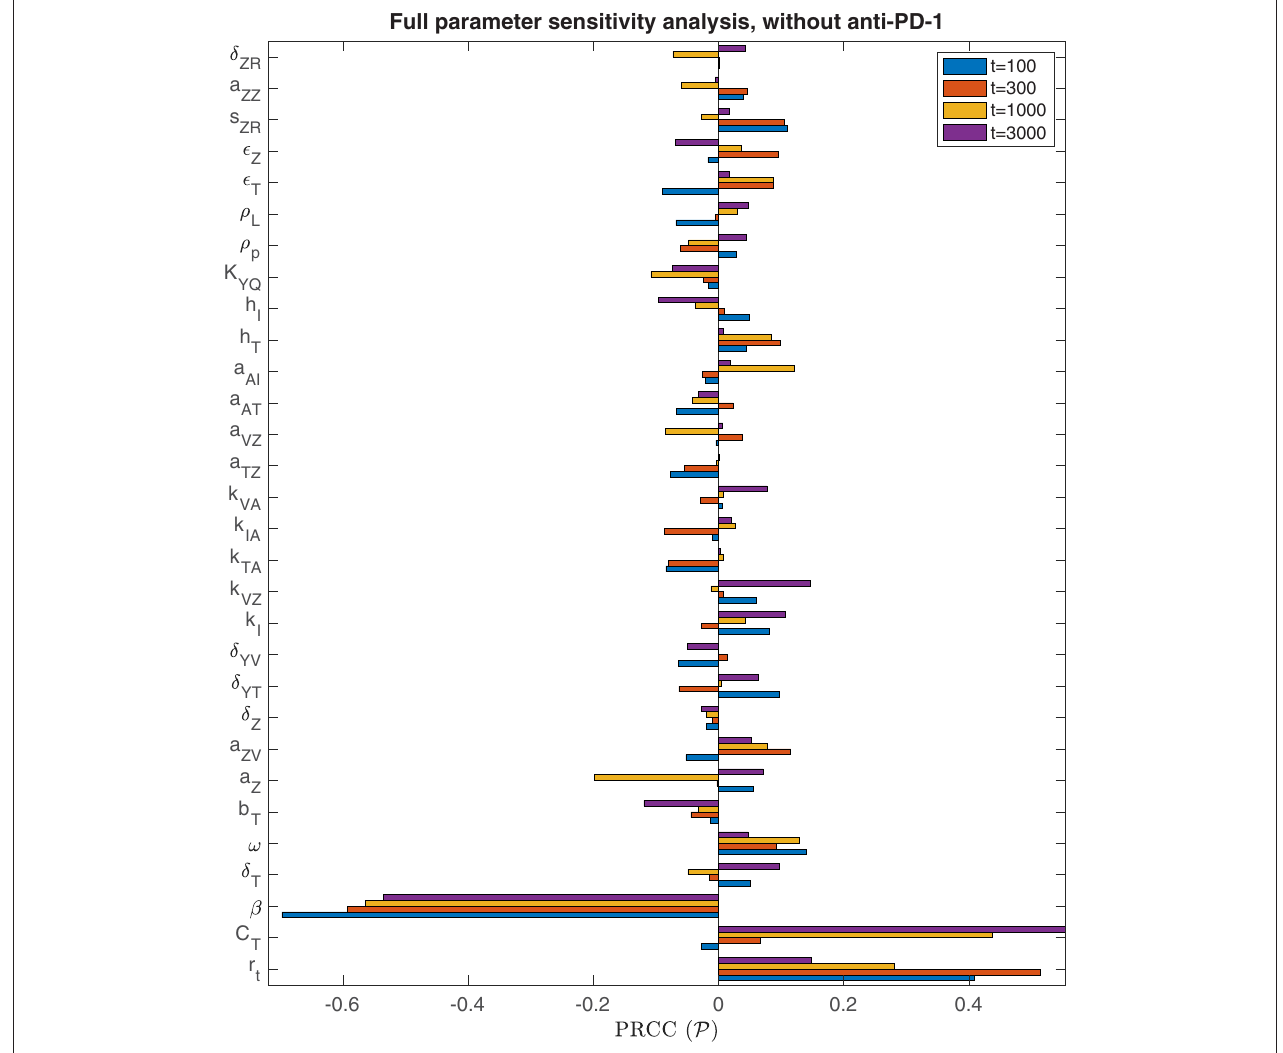
FIGURE 3 | Parameter sensitivity analysis without anti-PD-1. Bar plot of the partial rank correlation coefficient between each model parameter and the susceptible tumor population at the end of the simulation, shown for simulation end points at t = 100, t = 300, t = 1,000, and t = 3,000